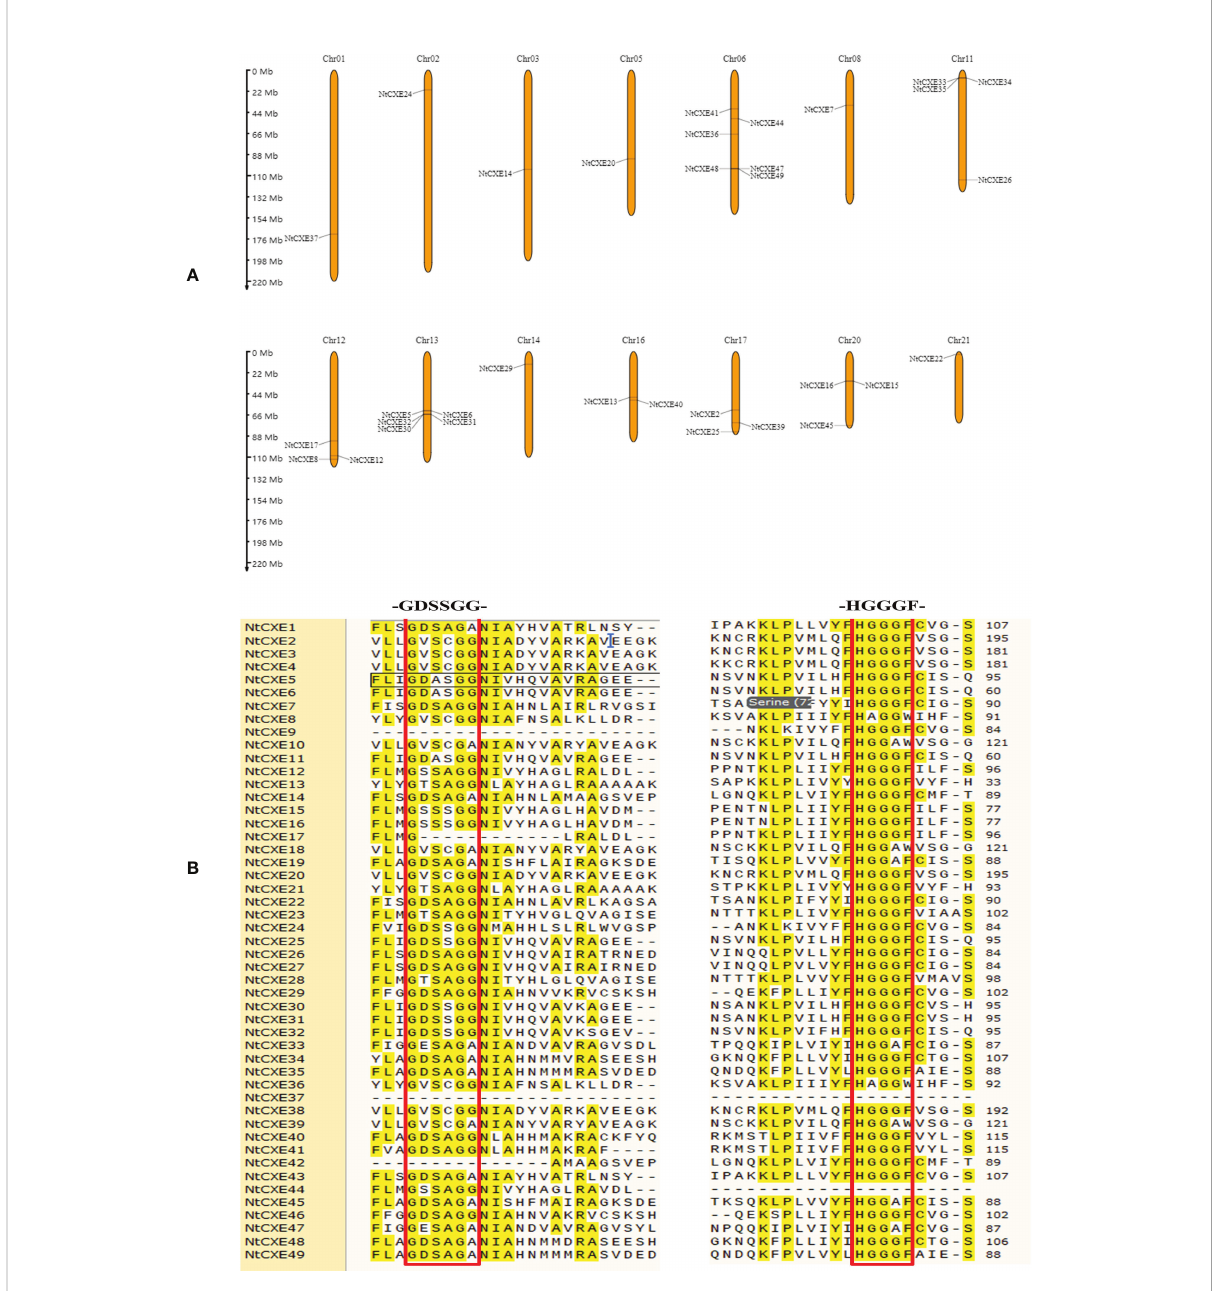
FIGURE 2 Analysis of genomic location, duplicated gene pairs, and sequence comparison of tobacco NtCXE proteins. (A) Chromosomal positions of the CXE genes. The chromosomal names are in red and are shown at the top, and the gene names are shown on the chromosome. The length of chromosomes is shown to scale. (B) Multiple sequence alignment of conserved domain of NtCXE proteins. The amino acid sequences were aligned using